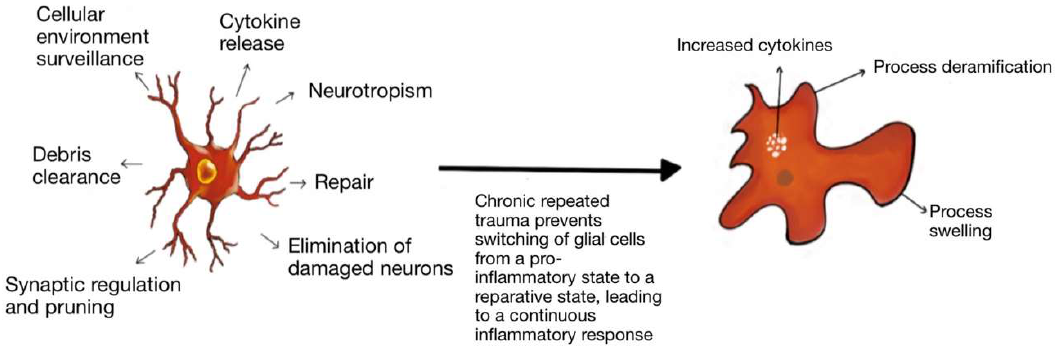
Figure 5. Microglial Priming: Microglia have a dual function in the brain and play a role in inflam- mation and repair. As microglia age, there is evidence of priming and more pro-inflammatory activity. Additionally, repeated trauma prevents the microglia from switching from its pro-inflammatory state to its reparative state, leading to a continuous inflammatory response and damage.